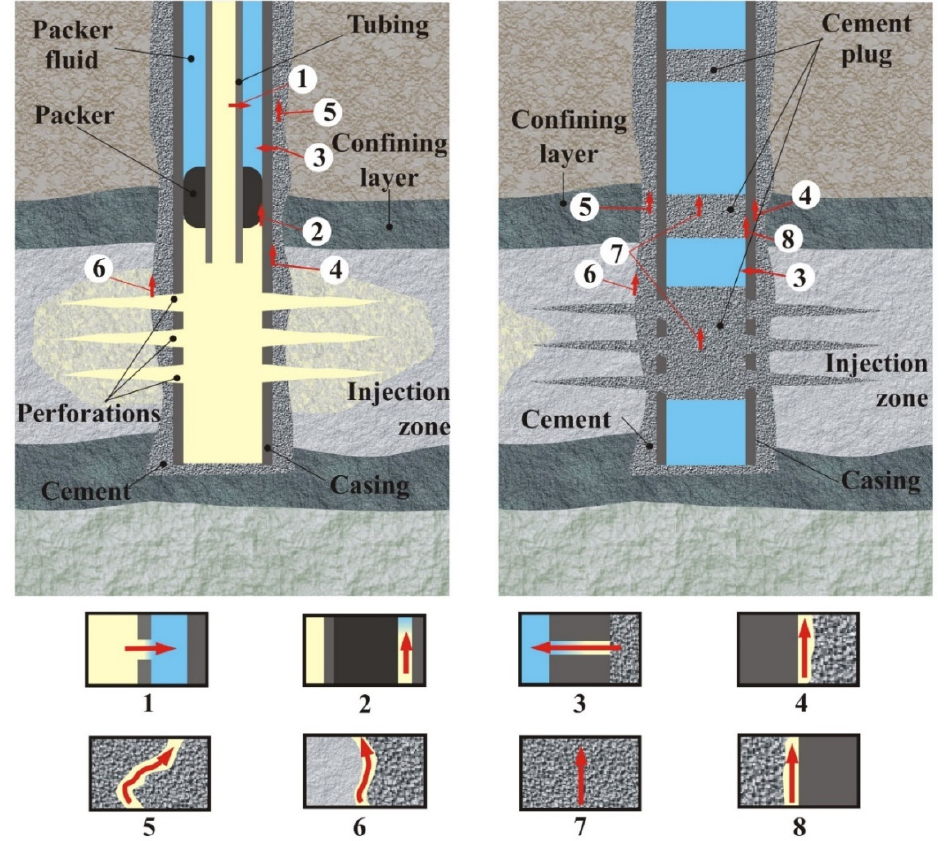
Figure 5. Possible injected waste migration pathways [81].